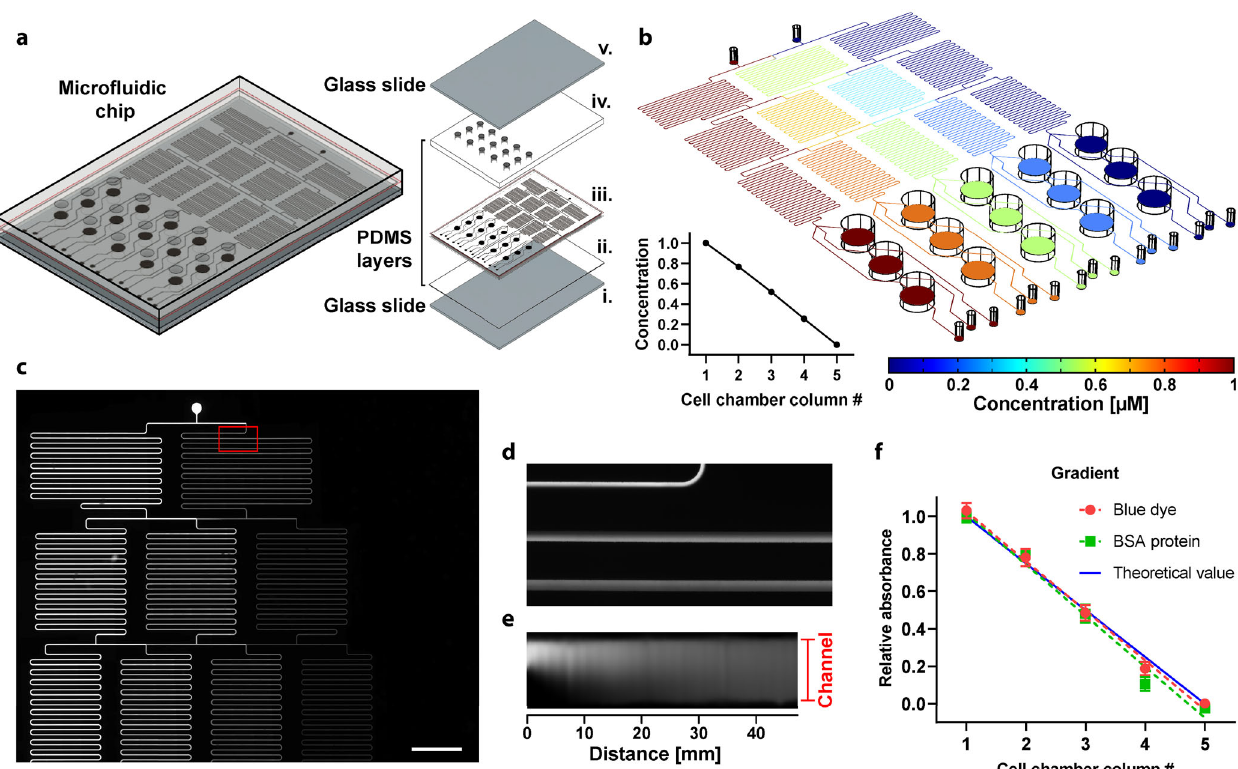
Fig. 3 Micro fl uidic dynamic BH3 pro fi ling platform. a Schematic representation of the chip including exploded view of all the parts: (i) lower glass slide, (ii) thin PDMS layer, (iii) channels & chambers PDMS layer (1 mm thick), (iv), chambers PDMS layer (2 mm thick), and (v) upper glass slide. b Simulation of peptide concentration along with the whole micro fl uidic platform. The coordinate of the slice plot is selected at the middle of the micro fl uidic channels. Relative concentration as a function of the cell chamber (inset fi gure). c Fluorescence image of the network of micro fl uidic channels after injecting fl uorescein in the left inlet and distilled water in the right inlet at a pressure of 100 mbar. d Zoomed view of the region where both solutions are mixed. e Fluorescence intensity along with the fi rst 47 mm of the mixer channel (total channel length is ~190 mm); Note that the image was processed in ImageJ to be plotted as a straight channel f . Colorimetric detection of BSA protein and relative absorbance of blue dye at the outlets of the chip measured at 562 and 640 nm, respectively, on a plate reader. Together with the blue dye, BSA protein was injected through one of the inlets, while MiliQ water was injected in the other (inlet pressure of 200 mbar). Data represent three independent experiments using different